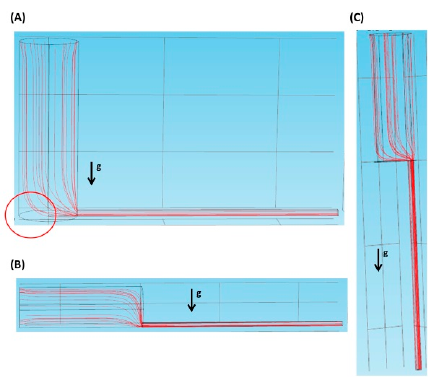
Figure 2. The flow streamlines in different inlets at a flow velocity of 0.0001 m/s. ( A ) The vertical inlet; ( B ) The parallel inlet; ( C ) The vertically parallel inlet.